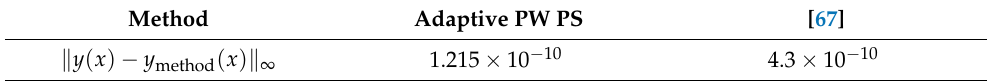
Figure 18. ( a ) The approximating polynomial y ( b ) Plot of the statistic ω i . Table 2. Comparison of the supremum norm of the approximation error for different methods.